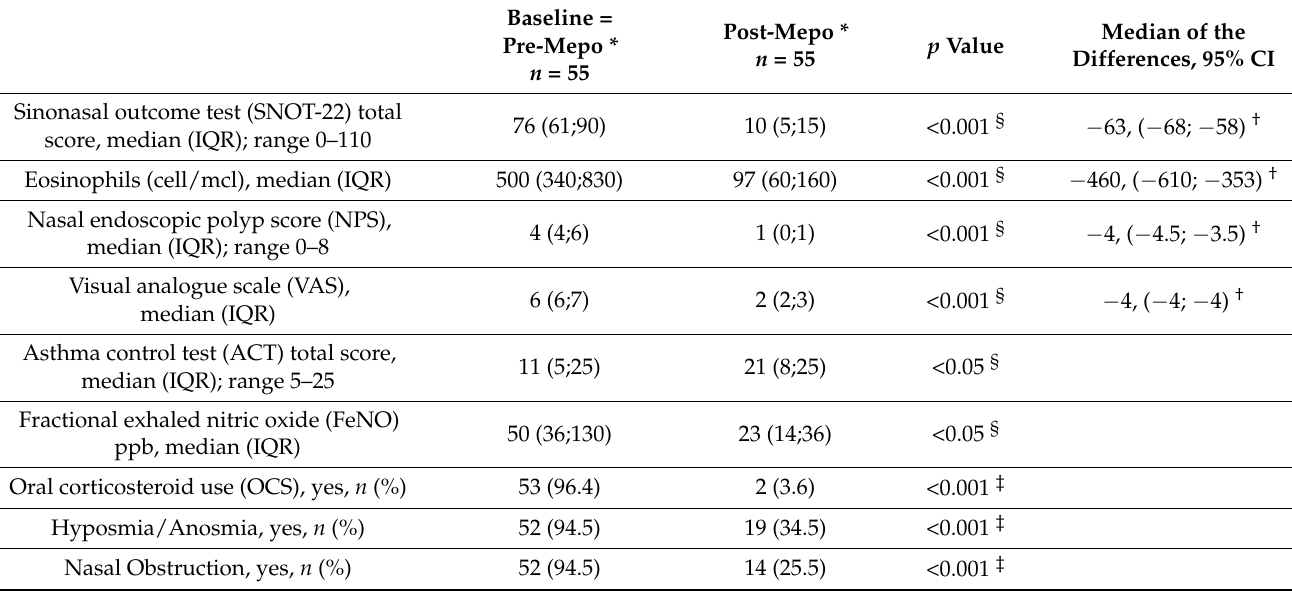
Table 2. Summary of patient-reported outcomes pre-Mepo = t0 and post-Mepo = t6. Baseline